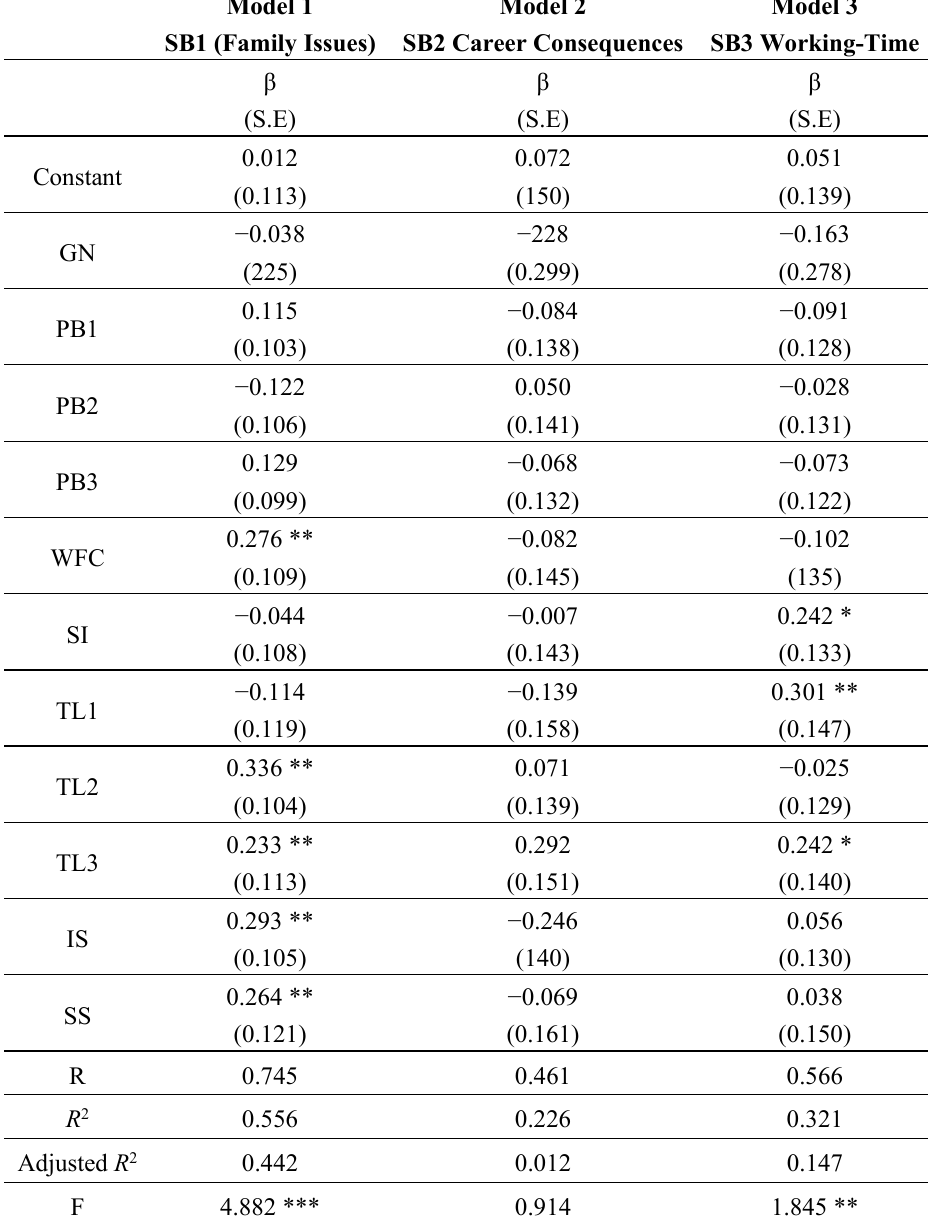
Table 3. Regression